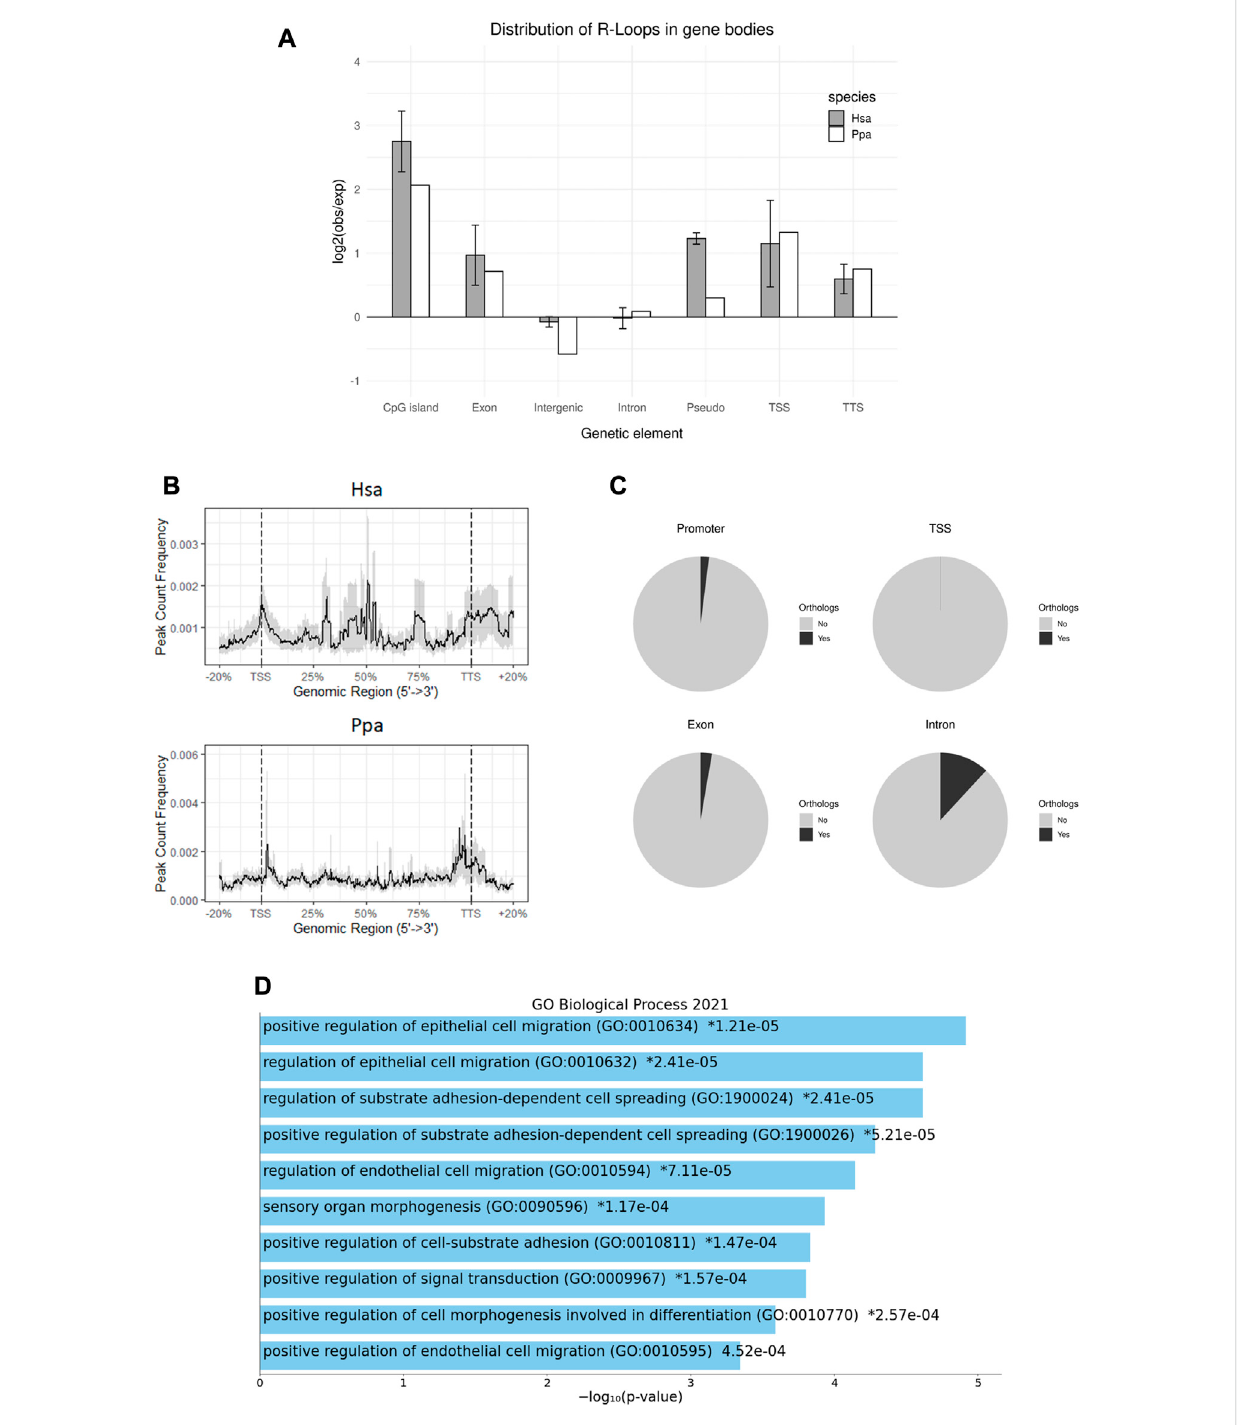
FIGURE 3 R-loop Distribution acrossgene bodies. (A) Genomicdistribution of R-loop peaks across genomic annotations comparedto theexpected genomic distribution in human and bonobo sperm. Error bars shows ±SEM among the biological replicates. (B) Metaplot of the R-loop distribution in human and bonobospermacrossgenebodies,relativetotranscriptionstartsiteandtranscriptionterminationsite. (C) PiechartsshowingtheproportionofR-loopsin in human sperm with an orthologous gene feature in bonobo. (D) Summary of GO Biological Process 2021 enrichment results of conserved introns between human and bonobo, ordered by p